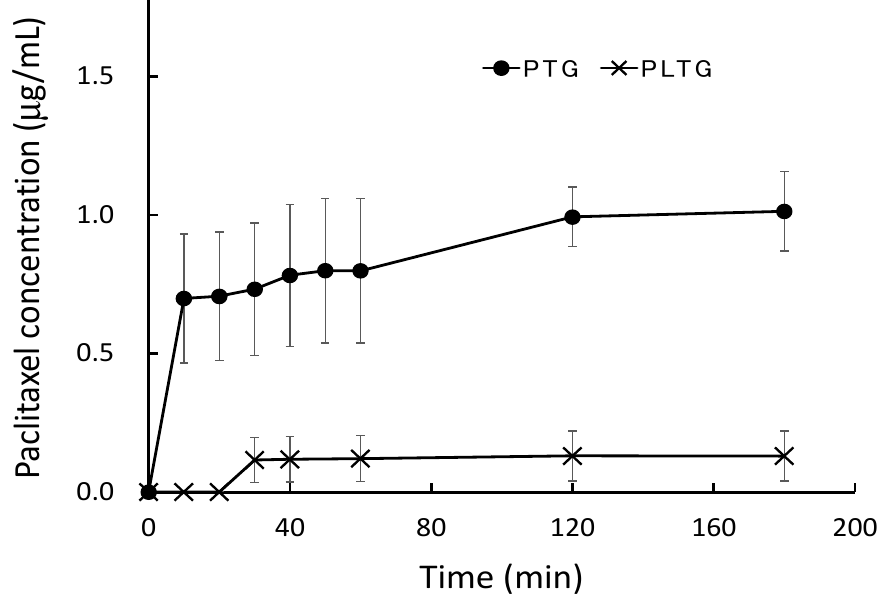
Figure 4. The leak behavior of paclitaxel from the temperature-sensitive gel. The apparatus shown in Section 4.7 was used. These samples were placed on a semipermeable membrane, the receiver solution was sampled at fixed intervals, and the concentration of paclitaxel in the sampled solution was measured using HPLC. The only paclitaxel detected using this method was the free form leaked from these gels of liposomes. Data are expressed as the mean ± SEM of n = 3.